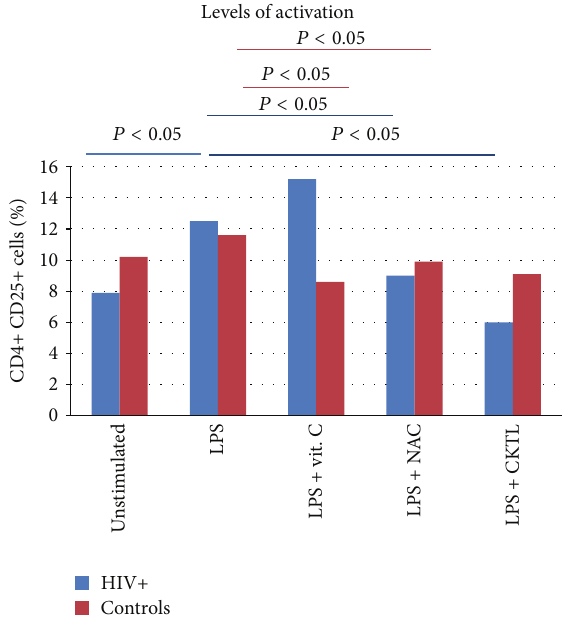
Figure 2: The figure shows the median %CD25 expression on CD4+ T cells under different experimental conditions for both HIV positive and control groups. LPS induced a significant increase in CD25 expression in HIV infection ( 𝑃 = 0.03 ) and this increase was similar to that of the controls ( 𝑃 = 0.68 ). Red and black lines at the top of the bars indicate significance.